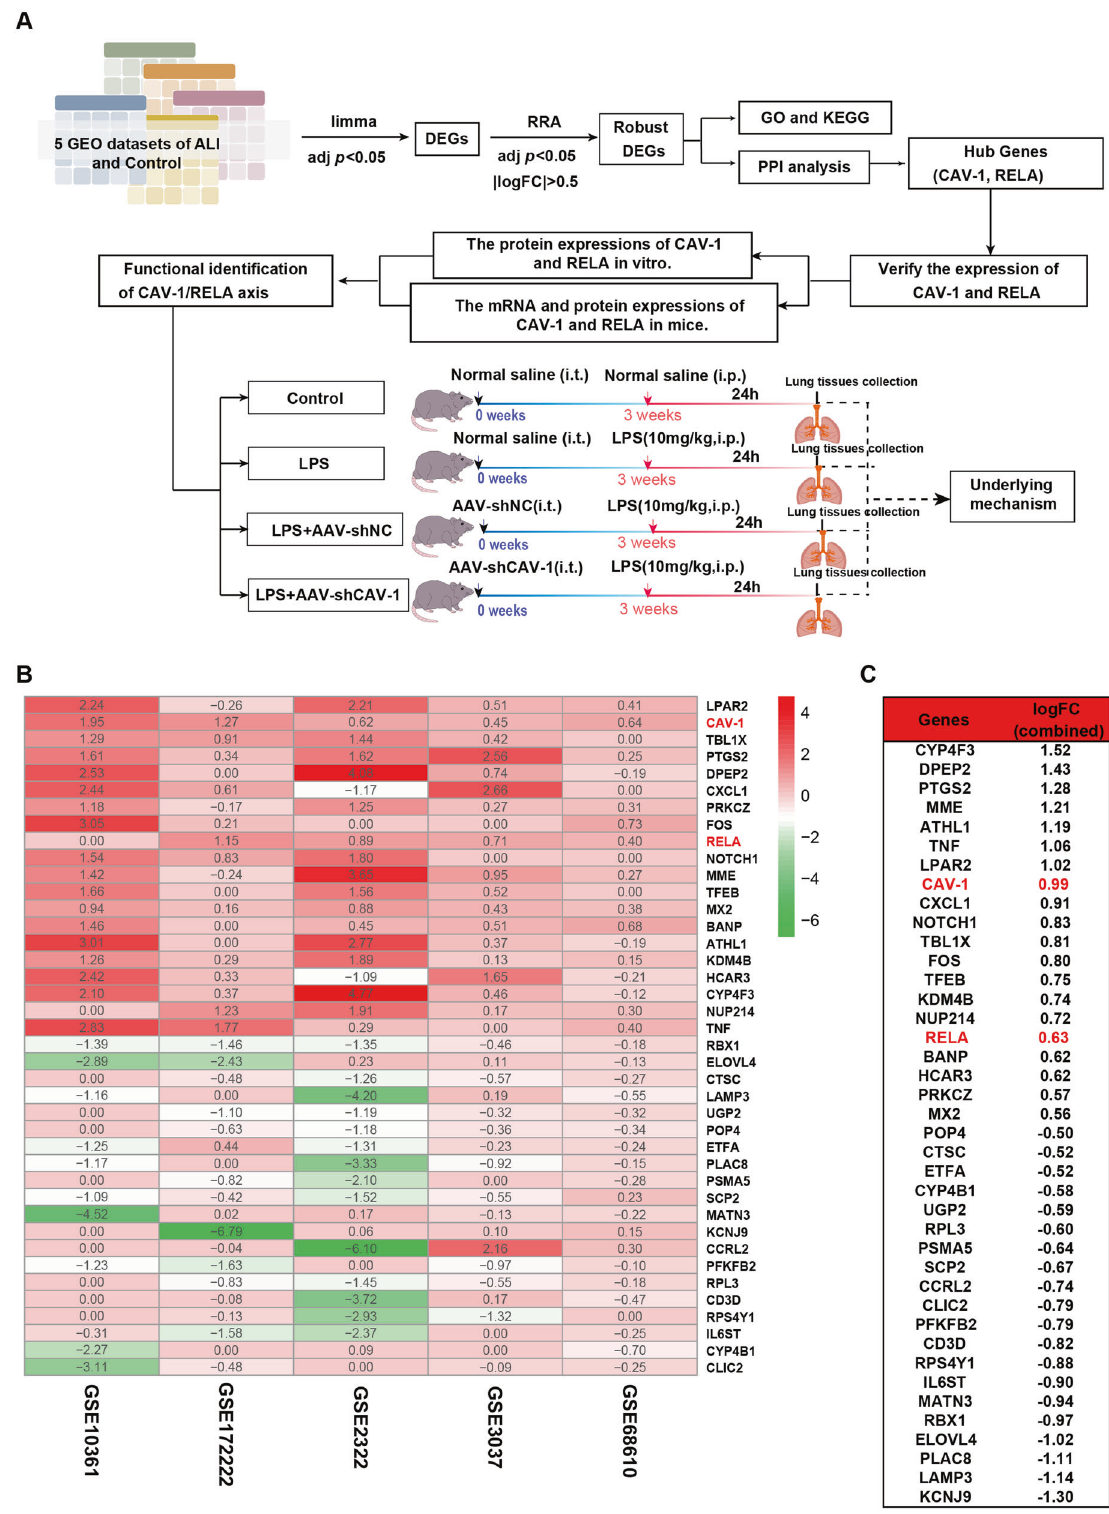
Fig. 1 The research scheme and RRA analysis of DEGs in ALI. A Research scheme and a fl ow framework. We analyzed 5 ALI datasets using bioinformatics, screened out common differential genes, and performed GO, KEGG, and PPI analysis on these differential genes. The mRNA and protein expressions of the CAV-1 and RELA were veri fi ed in vitro and in vivo. The functions of CAV-1 and RELA were further veri fi ed to explore the potential mechanism in ALI. B Heatmap demonstrated the 40 robust DEGs between the ALI and control. Twenty genes were promoted and twenty genes were suppressed in ALI. Red shows upregulated gene expression and green shows downregulated gene expression in ALI. Numbers in the heatmap indicate log2 FC of genes in the fi ve datasets compared with control groups. C The log2 FC of 40 DEGs was calculated from fi ve datasets. The log2 FC sums of CAV-1 and RELA were 0.99 and 0.63, suggesting these two genes were signi fi cantly upregulated in ALI.